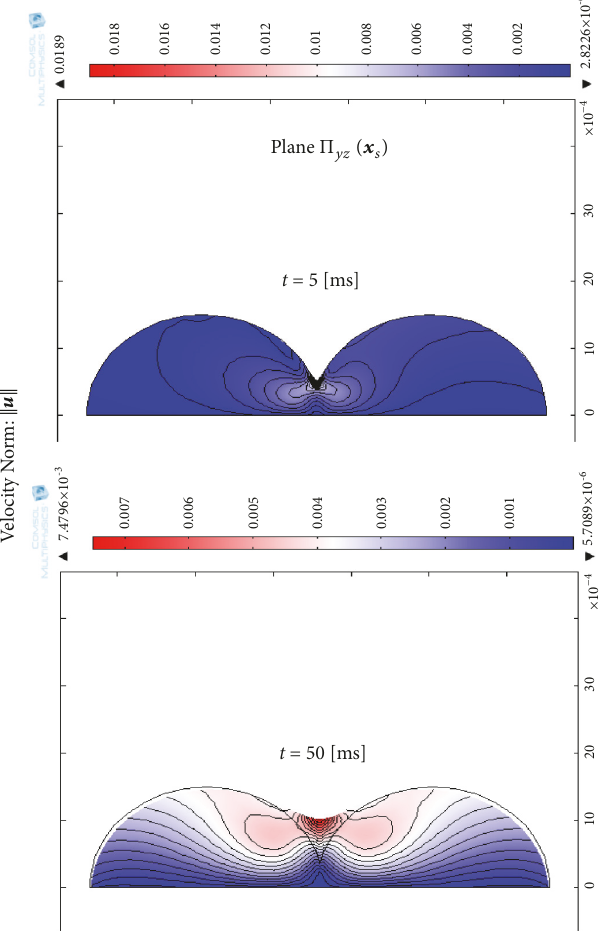
Figure 13: Two-dimensional plots of the velocity norm ‖ u ‖ of two interacting droplets of the same radius 𝑅 1 = 𝑅 2 on the plane Π 𝑥𝑧 ( x 𝑠 ) at times 𝑡 = 5 , 50 [ms]. The solid lines stand for the iso- ‖ u ‖ contours.